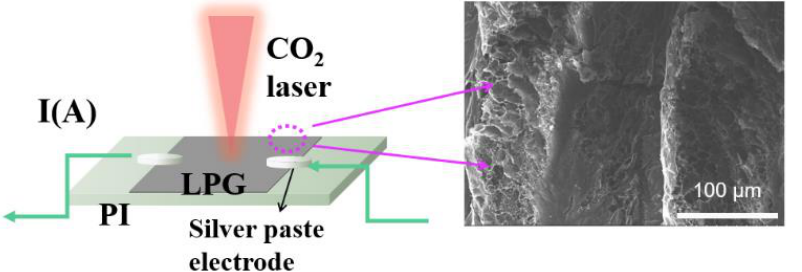
Figure 8. Schematic diagram of the preparation of laser-induced graphene, illustrated by the prepared scanning electron microscope. Inset: schematic diagram of electrically